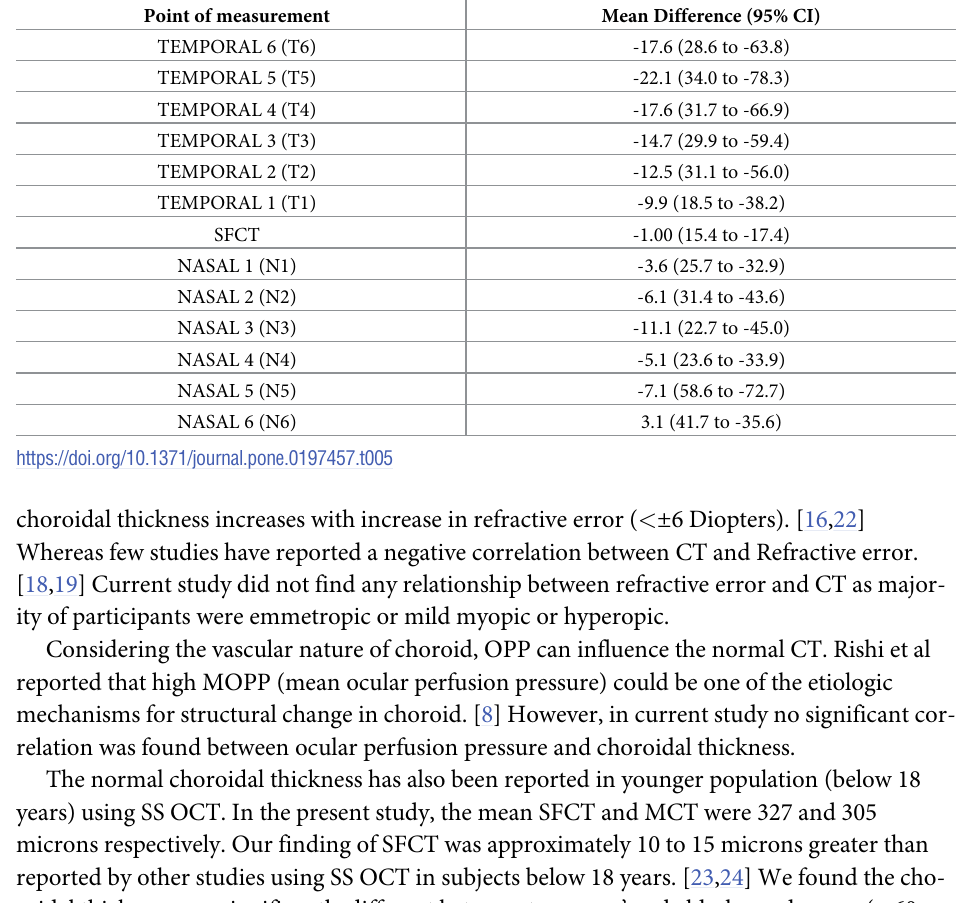
S1 Table. Statistical tests used in the study.